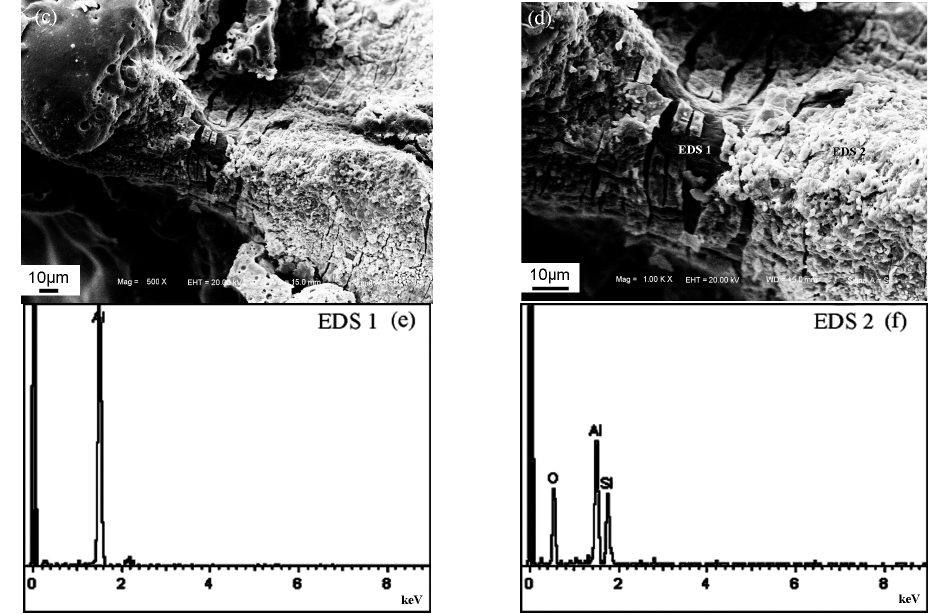
Figure 11. SEM image of the deformation of a foam strut: ( a ) and magnification ( b – d ) and its EDS analysis ( e , f ) at room temperature.